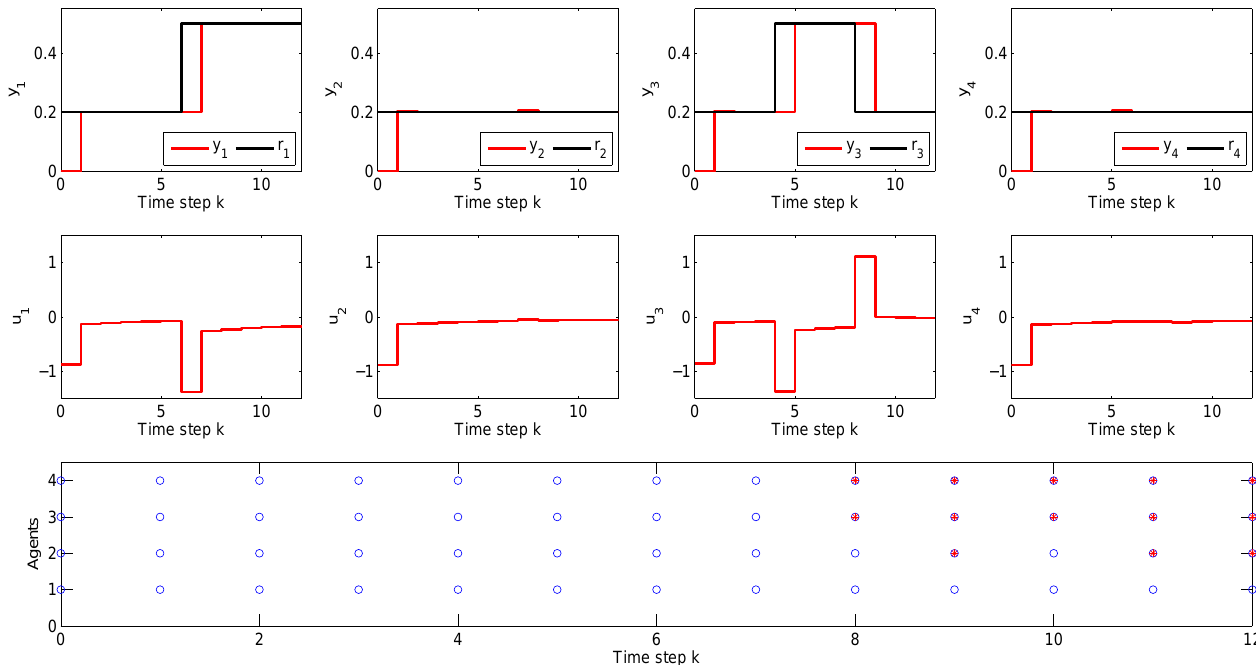
Figure 4. Reference tracking results (subplots 1–4), control efforts (subplots 5–8) and the corresponding coalitions formation (subplot 9) for a cyber-physical multi-agent system composed of 4 interconnected